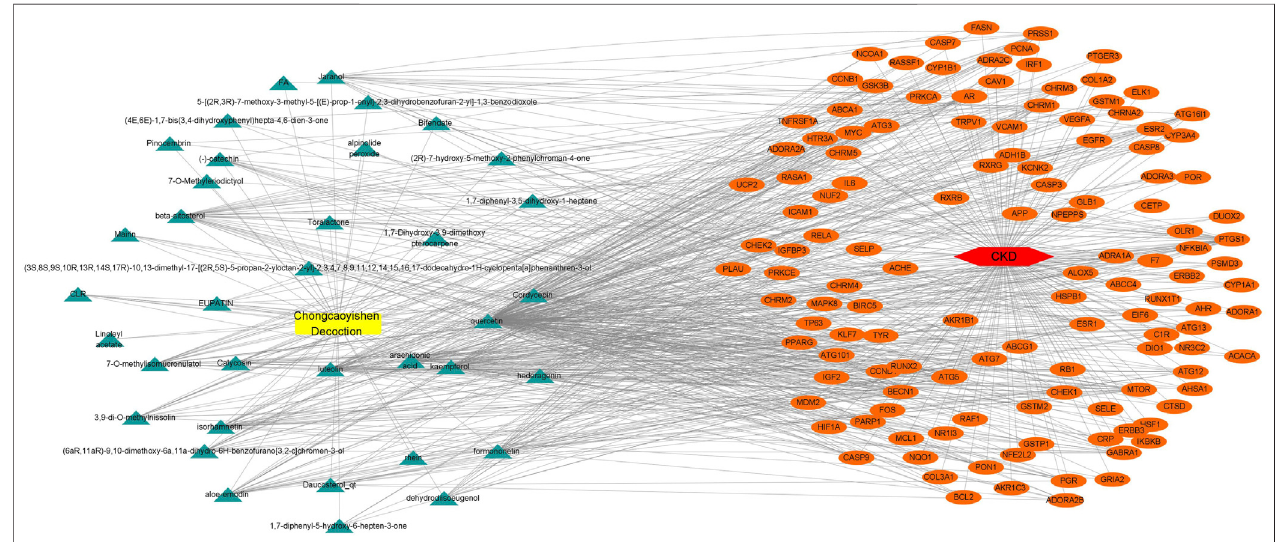
FIGURE 2 | Regulatory network of CCYSD in the treatment of